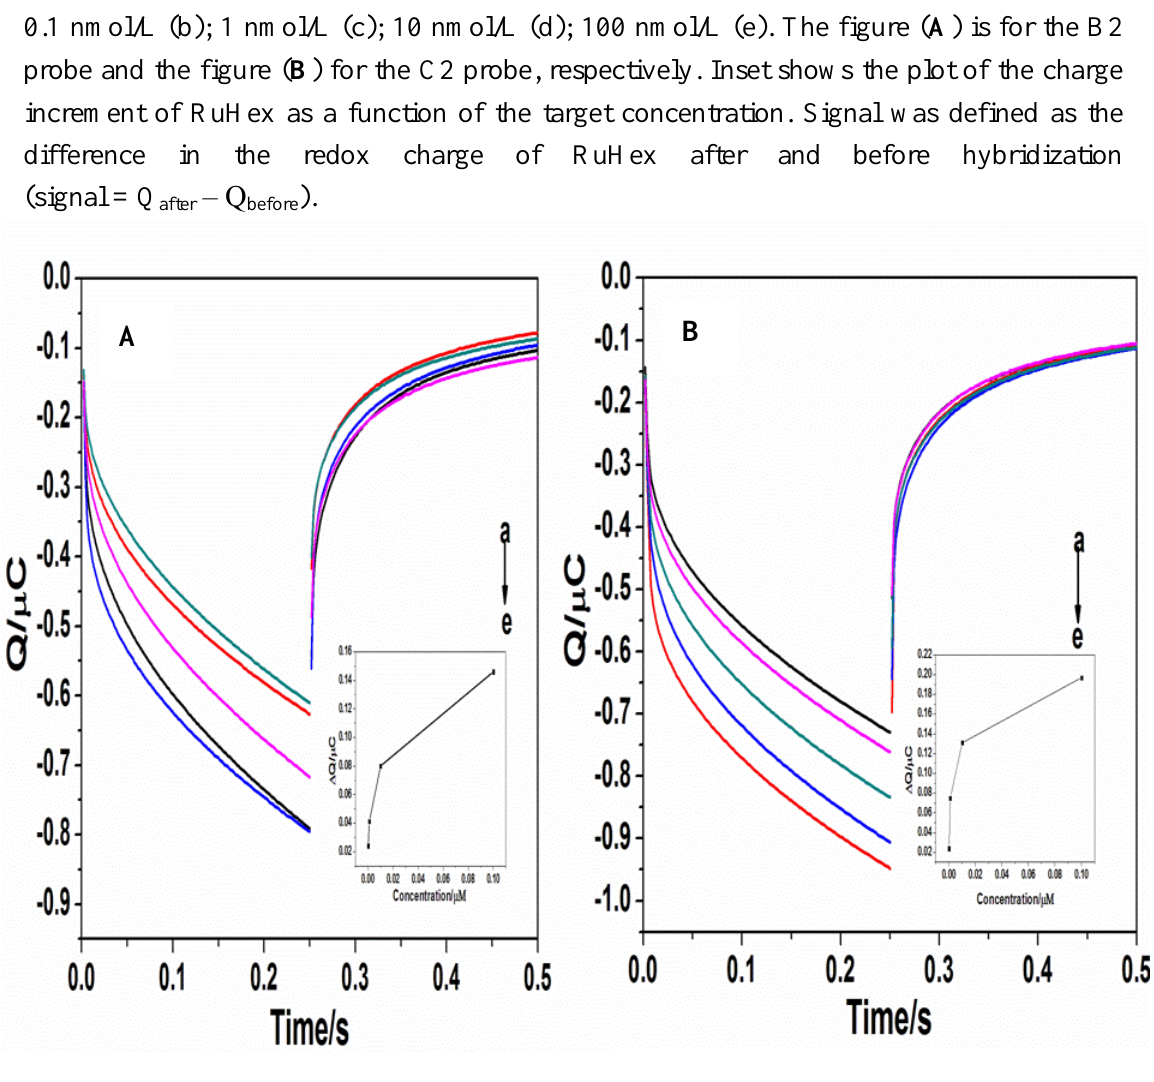
Figure 5. Chronocoulometry curves using 50 μM RuHex as redox indicator for a probe modified electrode after hybridization with different target sequence: 0 nmol/L